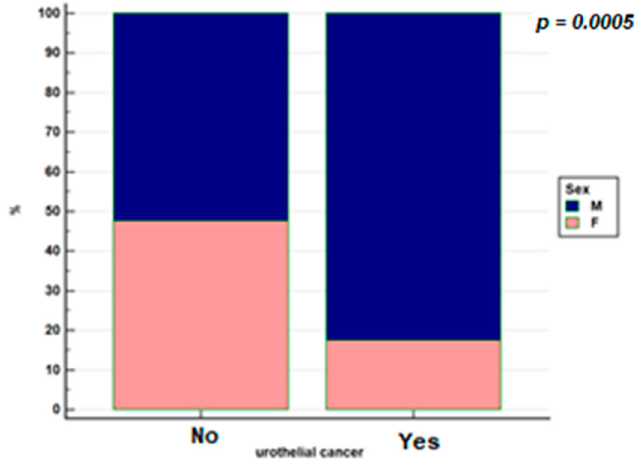
Figure 1. Distribution by gender in the population with IBD with urothelial cancer and without urothelial cancer.